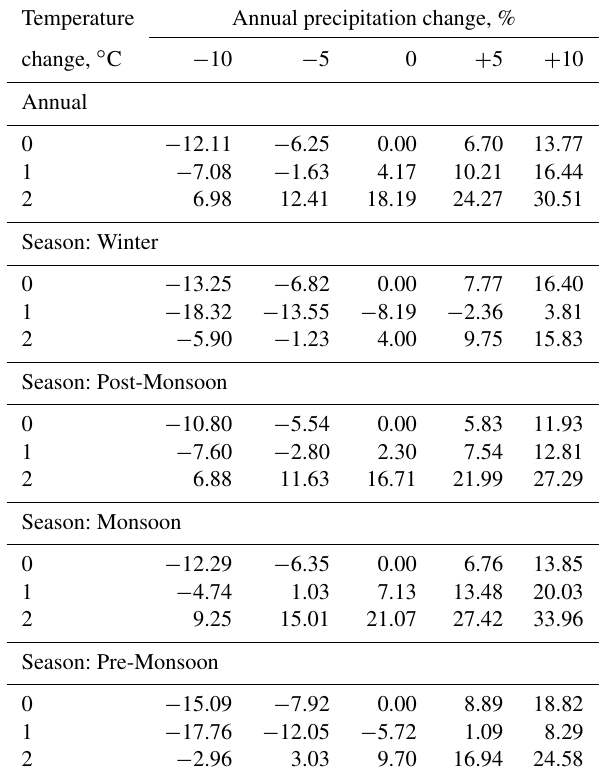
Table 1. Change (%) in mean annual and seasonal runoff under climate